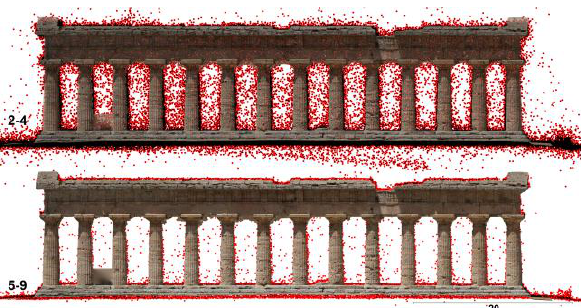
Figure 7. Image count filter: on top for values between [2-4], on the bottom for values between [5-9].